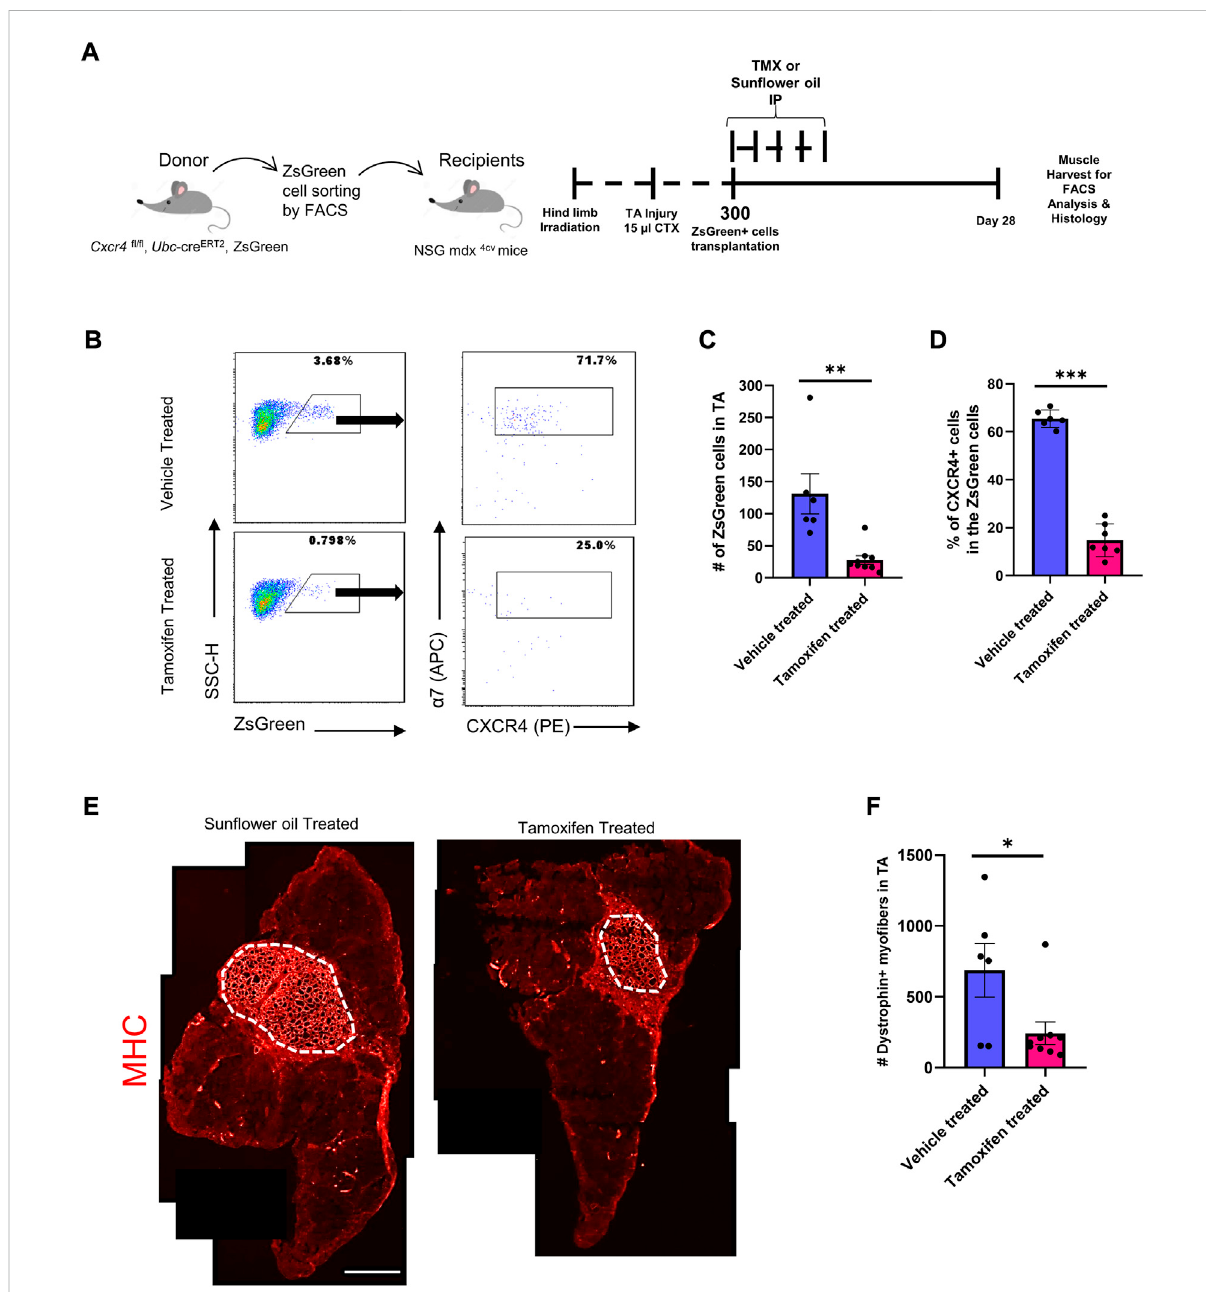
FIGURE 1 Cxcr4 Knockout impairs engraftment and repopulation of the satellite cell pool upon transplantation. (A) Schematic for the transplantation assay. (B) Representative FACS plots from both the TMX- and vehicle-treated groups showing the number of the ZsGreen + cells in the TA muscle after transplantation and the percent of CXCR4 + cells among the ZsGreen + ITGA7 + cell fraction. (C) Total number of ZsGreen + cells in TA muscles of recipient NSG-mdx4cv mice. Vehicle treated (n = 6). Tamoxifen treated ( n = 9). (D) Percentage of the CXCR4 + population in the ZsGreen + cells in recipient TA muscles. (E) Representative immuno fl uorescence images for TA muscles stained by Dystrophin (Red). Scale bar = 100 µm. (F) Total number of Dystrophin + fi bers in the TA muscles of vehicle and tamoxifen treated recipient mice. Vehicle treated ( n = 6). Tamoxifen-treated ( n = 9). Data are presented as mean ± SEM,* p < 0.05, ** p < 0.01 and *** p < 0.001 by t